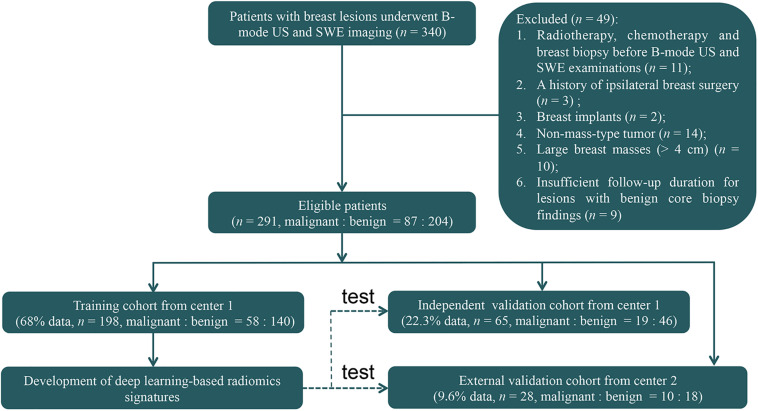
The flowchart shows the enrollment pathway in this study and the distribution of patients in the training and validation cohorts. US, ultrasonography; SWE, shear-wave elastography.